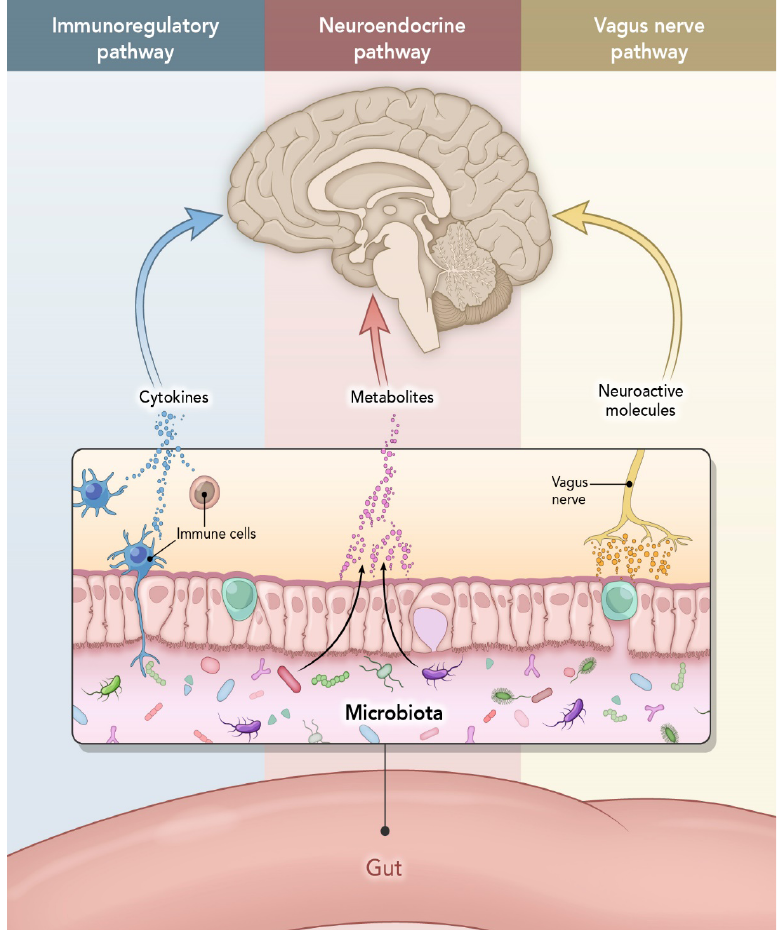
Figure 1. The interactions that occur at the GI mucosa level, and via neural, endocrine, or immune activity. Immunoregulatory pathway: a finely balanced system where microbiome interacts with immune cells to train and mature the components of the immune system while the immune system allows vital microbiome and host cell symbiosis. Neuroendocrine pathway: microbiome affects the HPA axis and the CNS via secretion of neurotransmitters, such as GABA, serotonin, melatonin, histamine, and acetylcholine. Vagus nerve pathway: vagus nerve establishes the connection between the brain and the GI tract and sends information about its state to the brain via afferent fibers